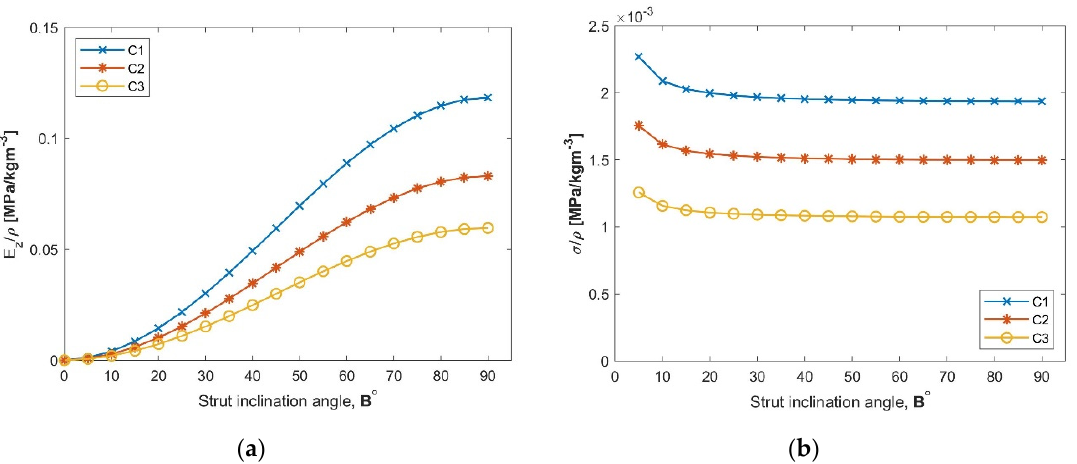
Figure 9. ( a ) Normalized compression sti ff ness and ( b ) normalized compression strength for the configurations subjected to study.